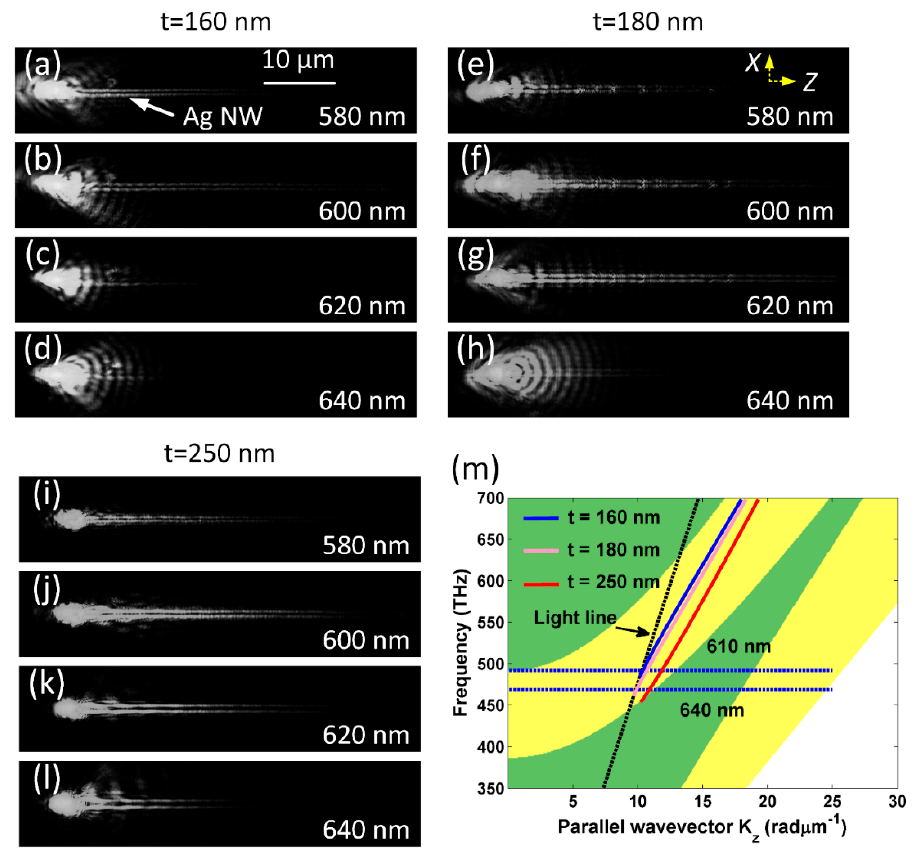
Figure 4. Controlling the propagation distance of the SPP waveguide mode with the top SiO 2 layer’s thickness. ( a – d ) The thickness of the top dielectric layer is t = 160 nm; ( e – h ) the thickness of the top dielectric layer is t = 180 nm; ( i – l ) the thickness of the top dielectric layer is 250 nm. The incident wavelength varied from 580 to 640 nm with 20 nm step, as labelled from ( a ) to ( l ). The scale bar in ( a ) is also applicable for the images in ( b – l ). The dimeter of the Ag NW was about 70 nm in all these images; ( m ) Simulated band structure of the multilayer and dispersion relation of the SPP waveguide mode. The projected photonic band structure of the dielectric multilayer for transverse electronic (TE) polarization. The yellow zone denotes the stop band. The solid lines denote the dispersion relations of BSW modes with different thickness of the top SiO 2 layer (t = 160, 180, and 250 nm).